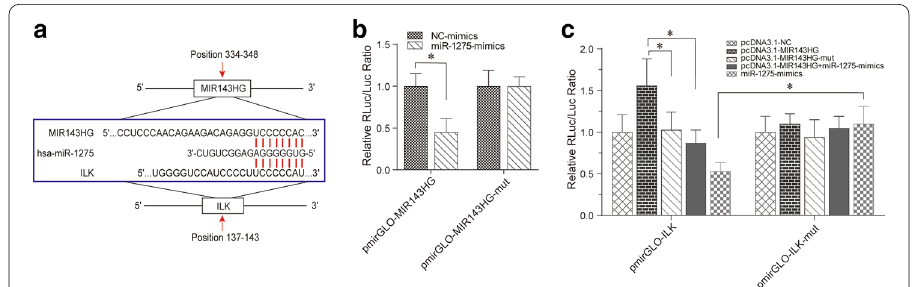
Fig. 4 MIR143HG acted as a ceRNA for miR-1275 to promote ILK expression. a Predicted binding sites for miR-1275 in the 3 ′ UTR of ILK or MIR143HG from the miRBase database. b , c The competing binding relationships among MIR143HG, miR-1275 and ILK were verified by dual-luciferase reporter assay. * P <